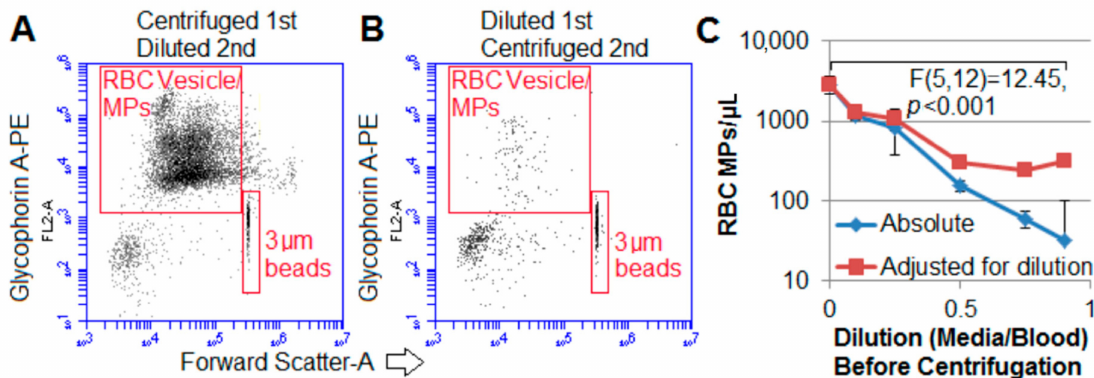
Figure 4. Diluting blood before centrifugation enhances microparticles or microvesicles (MV/MP) sedimentation: The timing of dilution (either before or after centrifugation) was examined. ( A ) Aliquots of donor blood were centrifuged first, their supernatant removed and diluted 1:1, and then examined. (B ) Identical aliquots of blood were first diluted 1:1, then centrifuged, and the supernatant examined. ( A , B ) Representative glycophorin A and FSC dot plots of two identical aliquots centrifuged for 5 min at 50 × g then diluted or the reverse. Immediately prior to examination with flow cytometry, 3 µ m counting beads were added to doubly confirm the cytometer reported volumes, and the dot plots displayed were of identical volumes (representative of 4 donor units). ( C ) Proof-of-principle showing as the blood became more diluted, centrifugation (for 1500 × g for 15 min) resulted in significantly fewer RMVs; n = 3 (1 of the aforementioned 4 samples with the most MVs/MPs performed in triplicate).